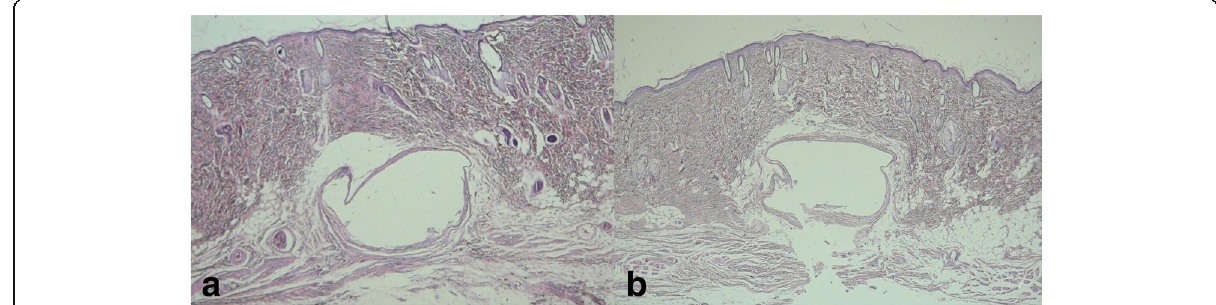
Fig. 7 a The sample of the control group at day 60 (H&E, ×40). b The sample of the study group at day 60 (H&E;